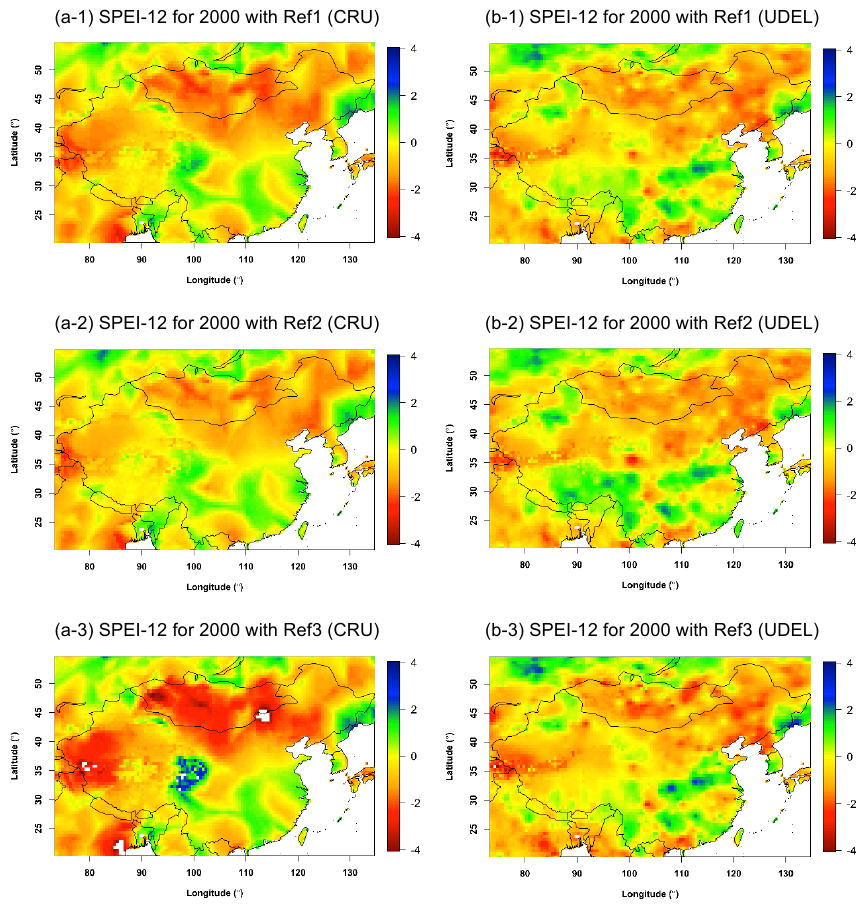
Figure 13. Spatial distribution of SPEI-12 for three different reference periods (Ref1, Ref2 and Ref3 in Table 2) based on the (a) CRU and (b) UDEL datasets in East Asia in 2000 as an example. Table 6. Spatial extent (%) (number of grid points in each drought category relative to the total number of grid points) of major drought events in different reference periods based on the CRU and UDEL